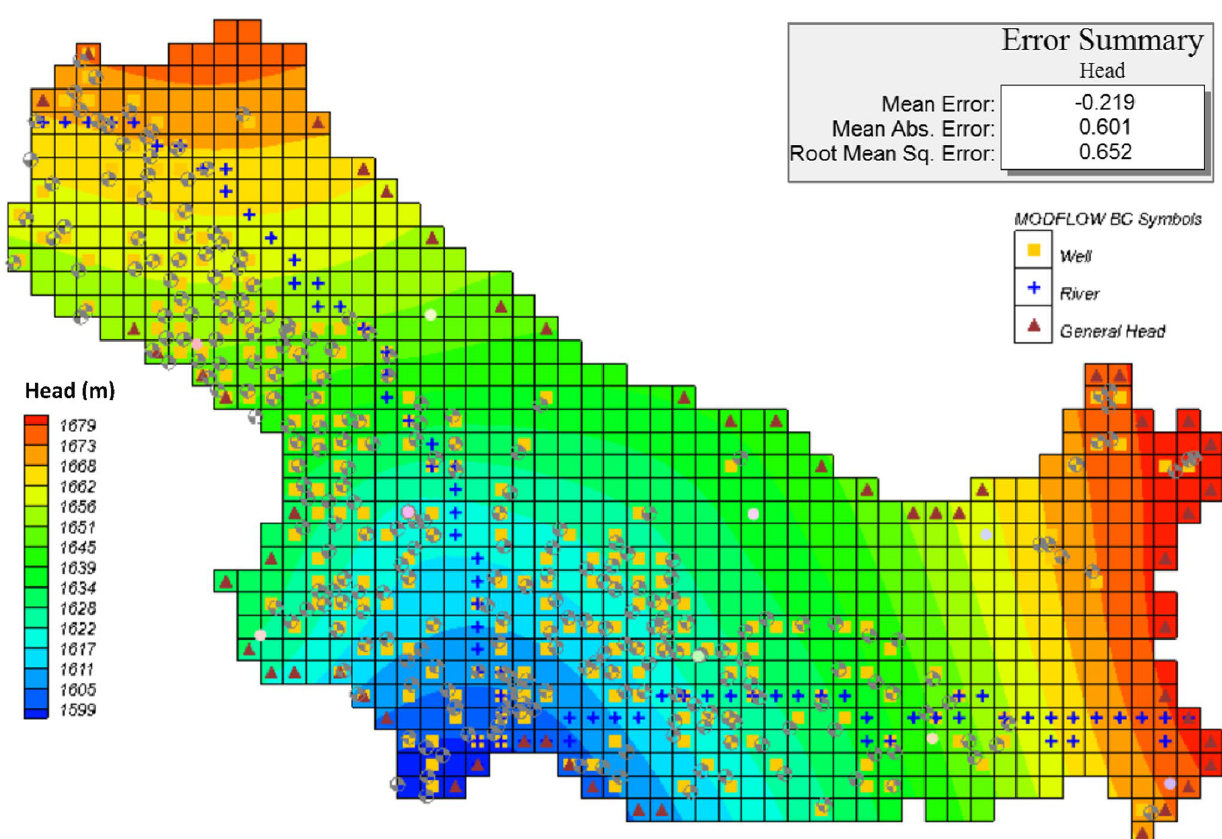
Fig. 4 Components of prepared numerical model and GWL in the plain for steady state